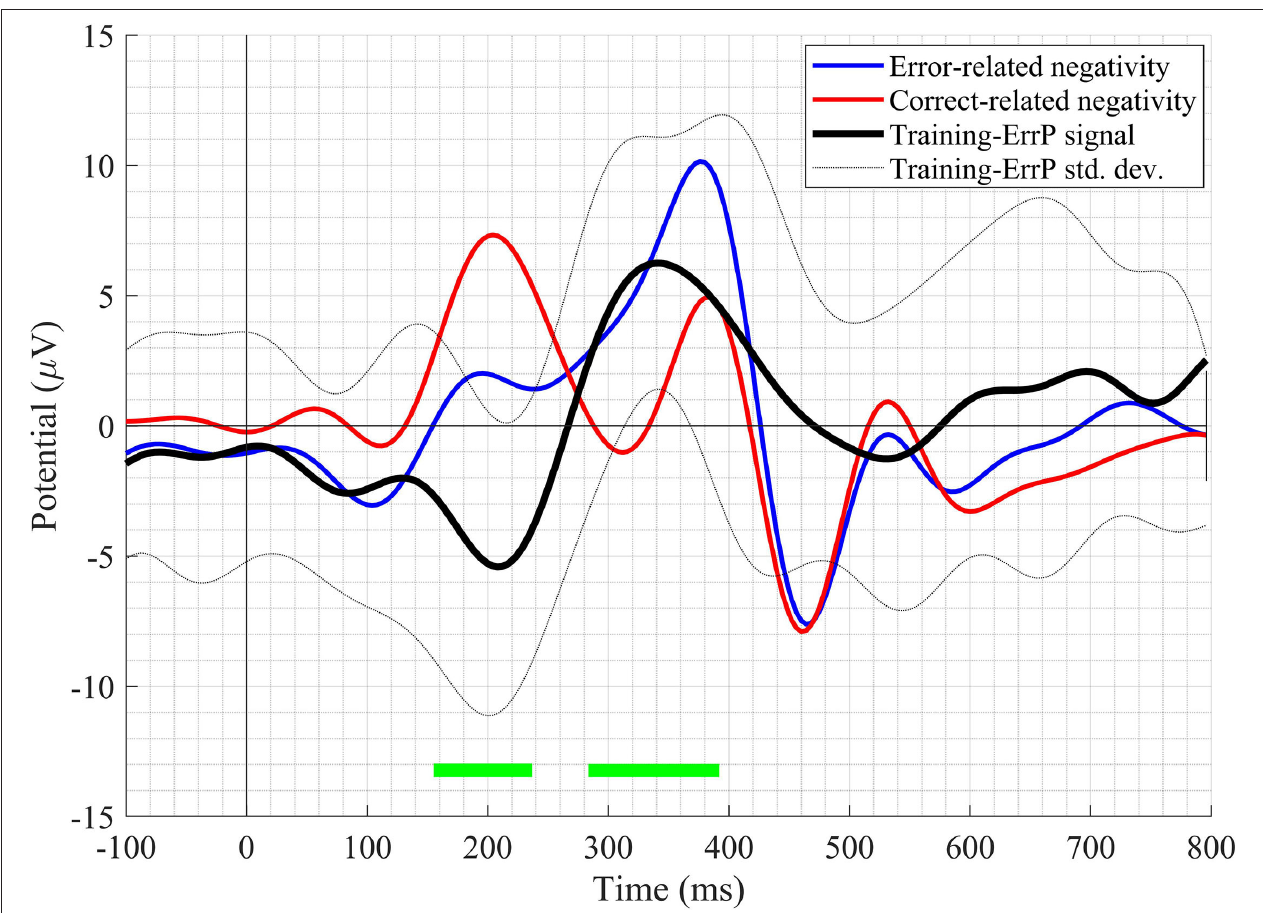
FIGURE 5 | The grand-average waveform of error-related negativity, correct-related activity, and Training-ErrP signal at the Fz electrode location. The green-bars mark the time-points when the Training-ErrP signal is statistically significantly different against zero after cluster-based multiple comparisons correction. For illustration purposes, the waveforms have been smoothed out with a 10Hz low-pass finite impulse response (FIR)